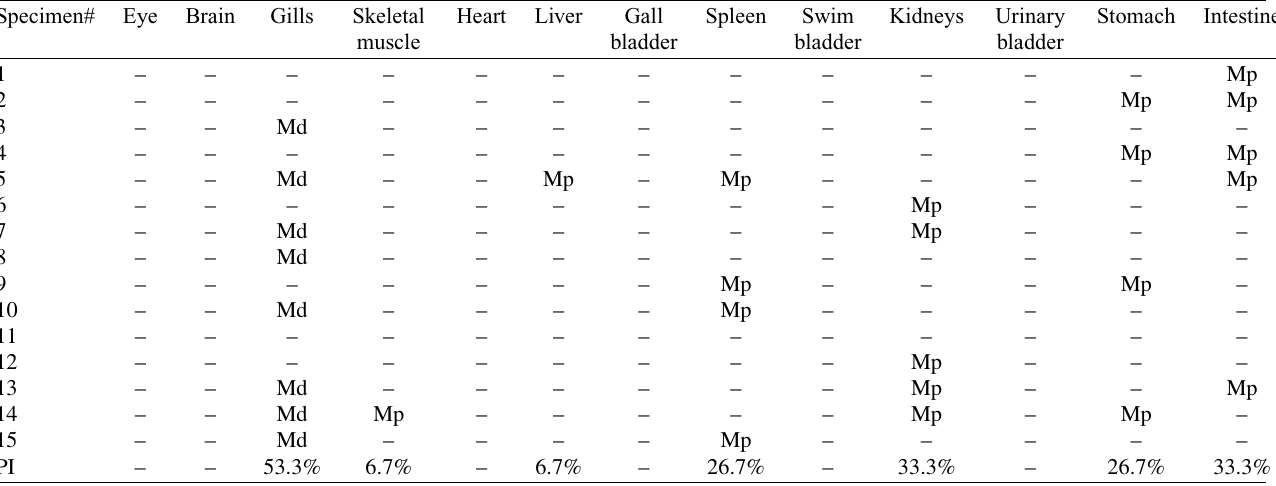
Table 1. Presence/absence of Myxobolus infection in the organs of P. duriense examined, as determined by light microscopic observations.